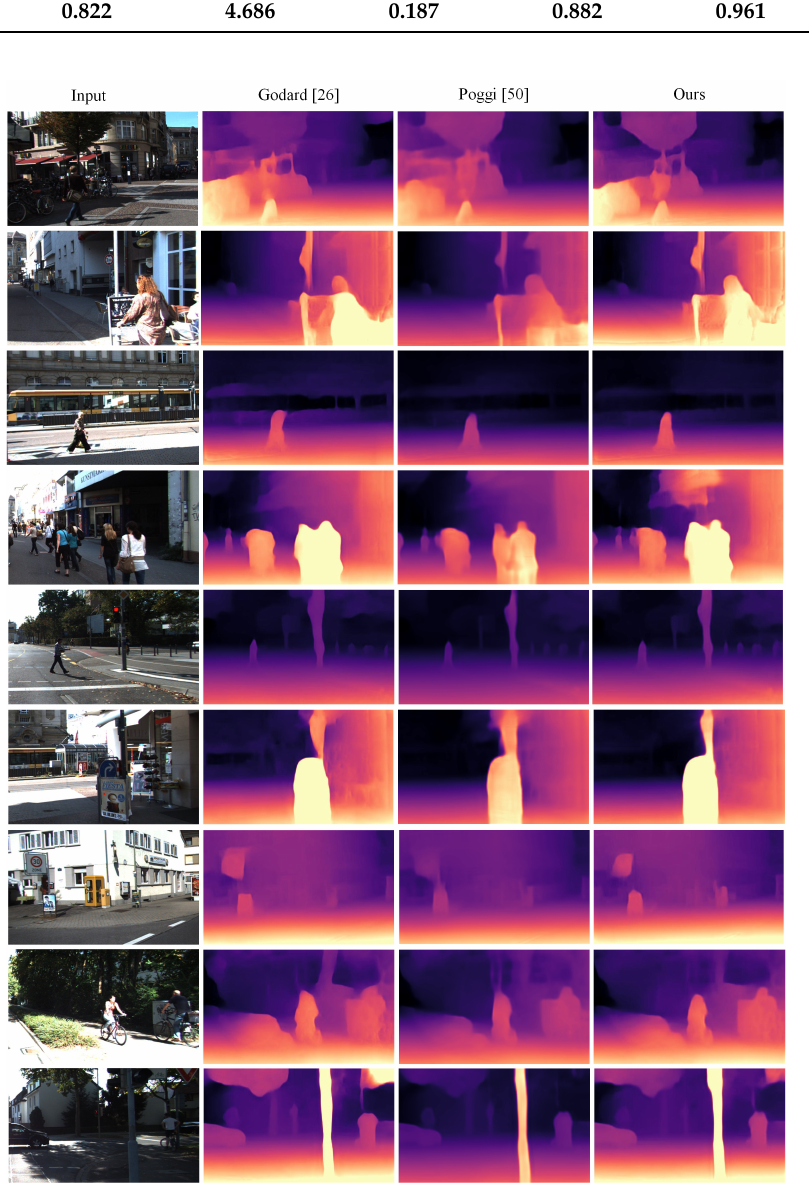
Figure 4. Qualitative results on the KITTI Eigen split. Our model produces depth maps with sharper object boundaries in most cases, which reflects the superior quantitative results in Table